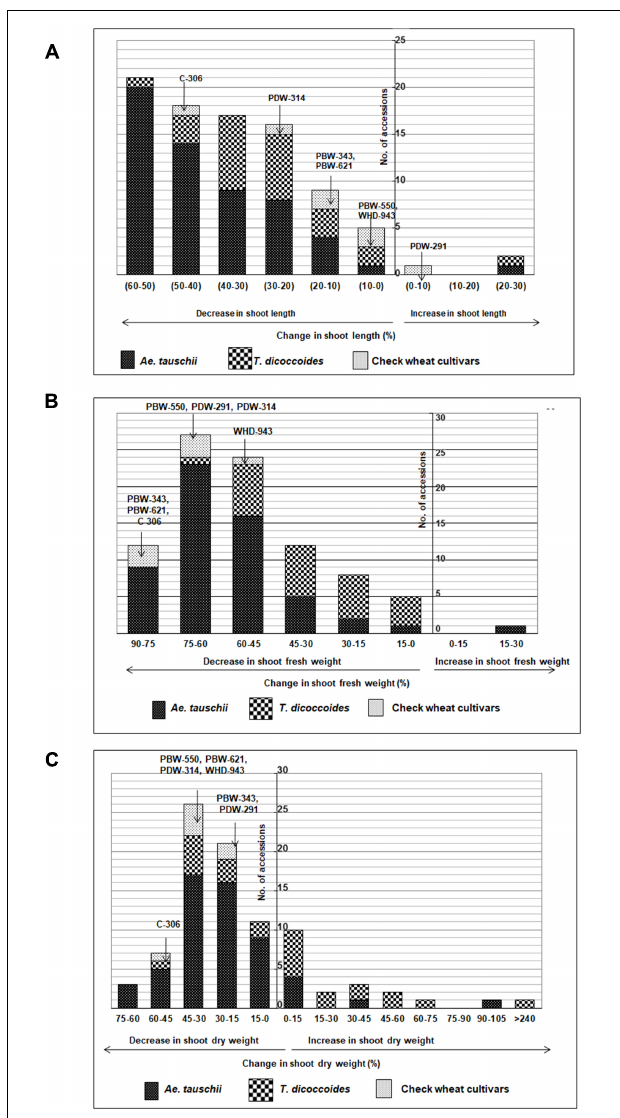
FIGURE 5 | Distribution of accessions of Ae. tauschii , T. dicoccoides and check wheat cultivars with regard to change in (A) shoot length, (B) shoot fresh weight, and (C) shoot dry weight under well watered and water stress conditions.